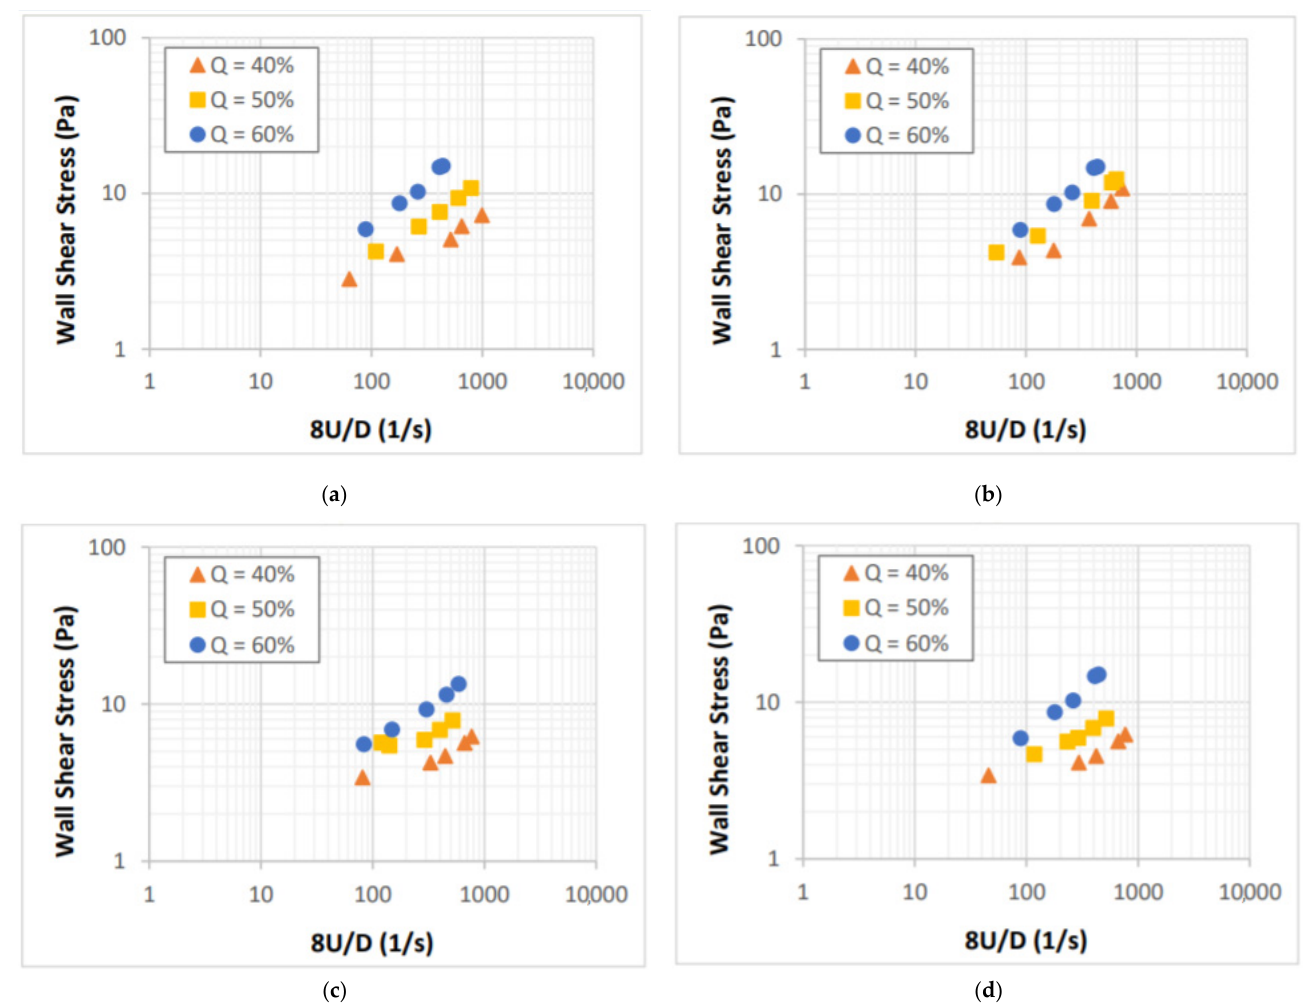
Figure 6. Shear stress vs. nominal Newtonian shear rate for: ( a ) 5%, ( b ) 9%, ( c ) 14%, and ( d ) 18% CaCl 2 foams.